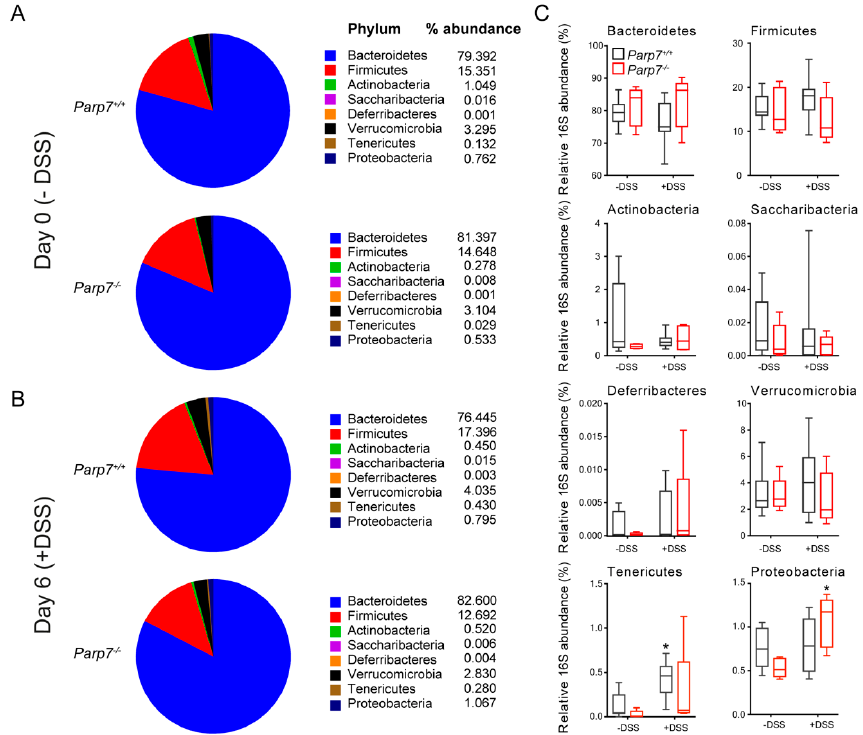
Figure 6 . DSS perturbs the composition of intestinal microbiota differently in Parp7 − / − and Parp7 +/+ mice. ( A – C ) Fecal pellets were collected from Parp7 − / − and Parp7 +/+ mice ( A ) before exposure to DSS (day 0) and ( B ) after 6 days with 2% DSS in their drinking water. The proportion of different bacterial phyla was quantified by RT-qPCR using the 16S RNA as described in Materials and Methods. * p < 0.05 two-way ANOVA compared with genotyped-matched and DSS treated animals.